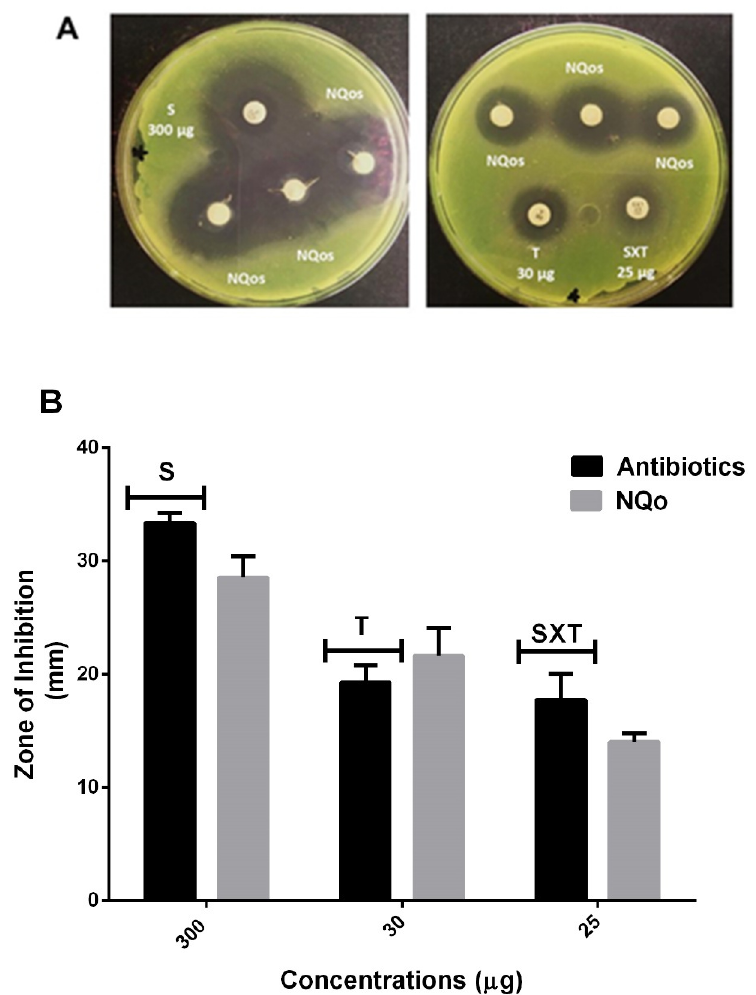
Figure 2. Growth inhibition zone of NQo on Pseudomonas sp. ( A ) Antibiogram photographs on agar; ( B ) graphical representation of comparative inhibition zone between conventional antibiotics. S = streptomycin; T = tetracycline; SXT = trimethoprim/sulfamethoxazole and NQo.